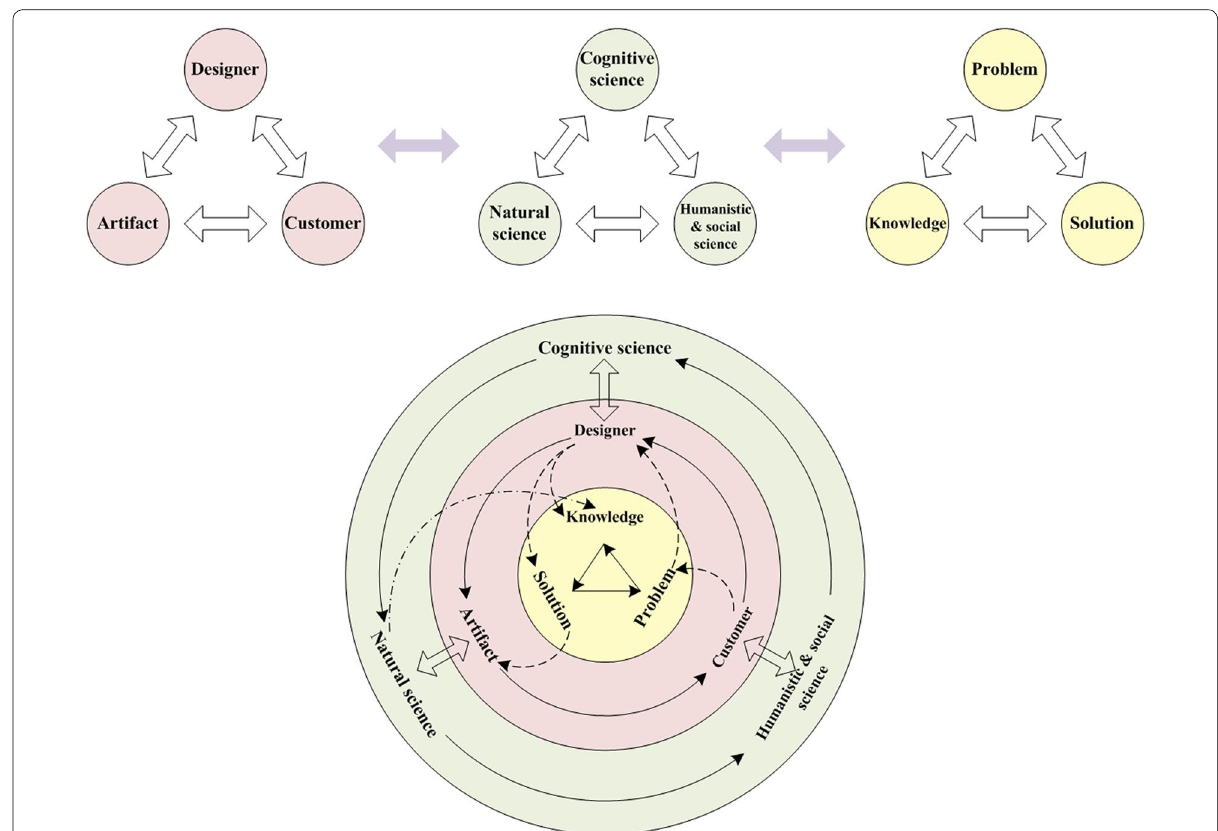
Figure 3 Essence of innovative